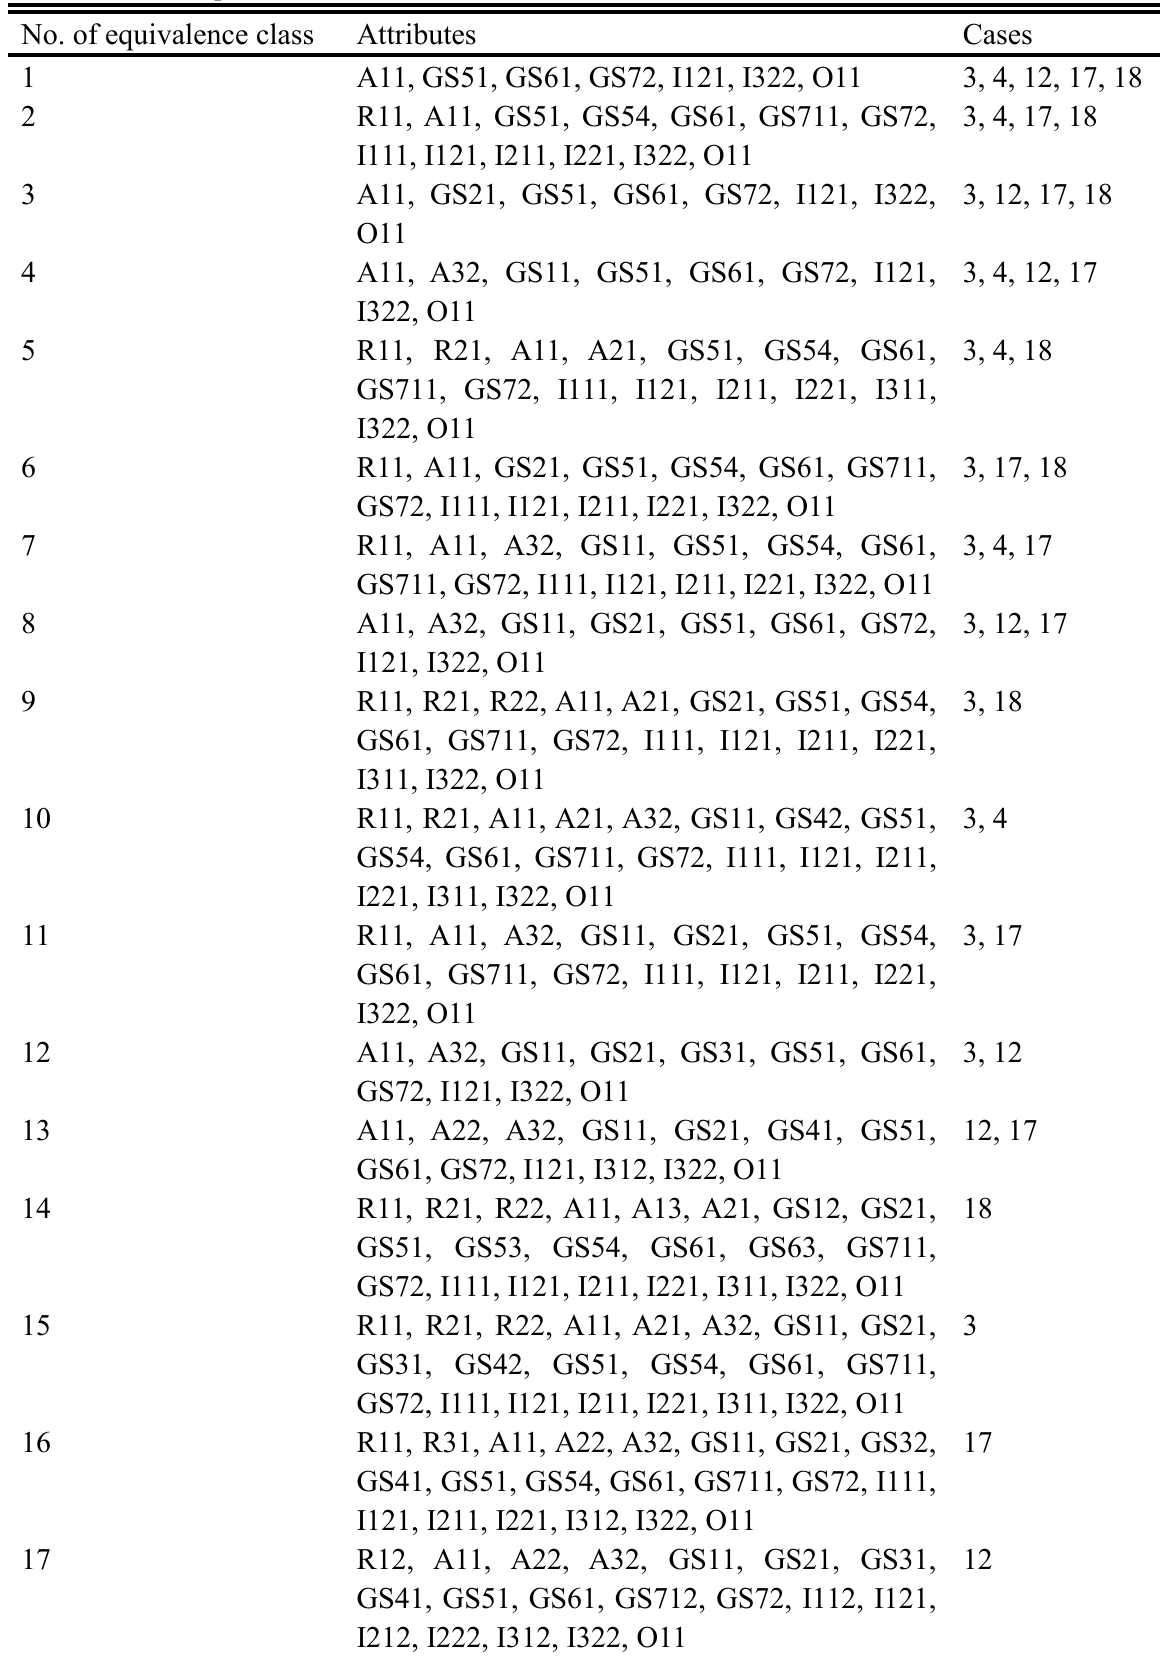
Table A1.2: Equivalence classes of the